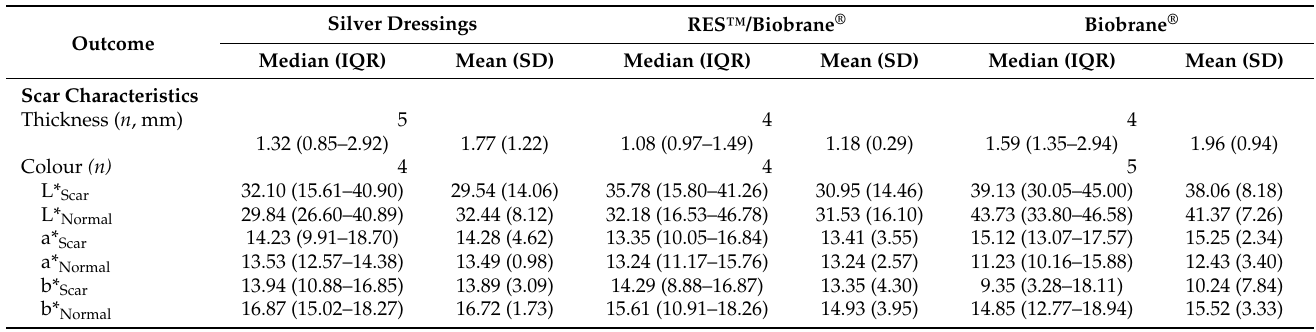
Table 4. Long-term secondary outcomes at secondary endpoint, at 12-months post burn injury, as reported by